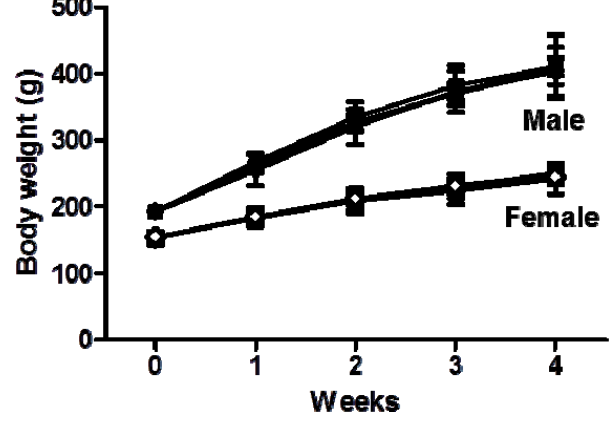
Figure 1. Growth curves for SD rats treated with C. setidens for 4 weeks. ( ● ○ ) Group 1 (control); ( ■ □ ) Group 2 (1250 mg/kg body weight per day); ( ▼ ▽ ) Group 3 (2500 mg/kg body weight per day); ( ◆ ◇ ) Group 4 (5000 mg/kg body weight per